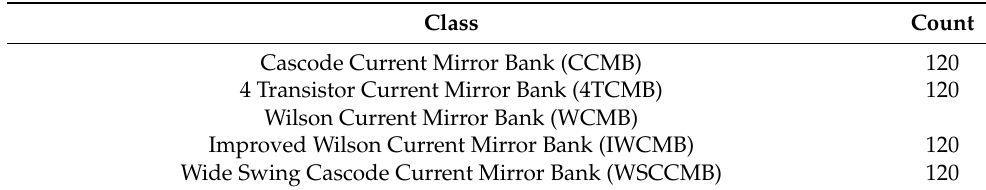
Table 15. Five classes count after performing “Hyperphysical Augmentation” for increasing the number of samples from 150 to 600, and thus 120 samples per class.